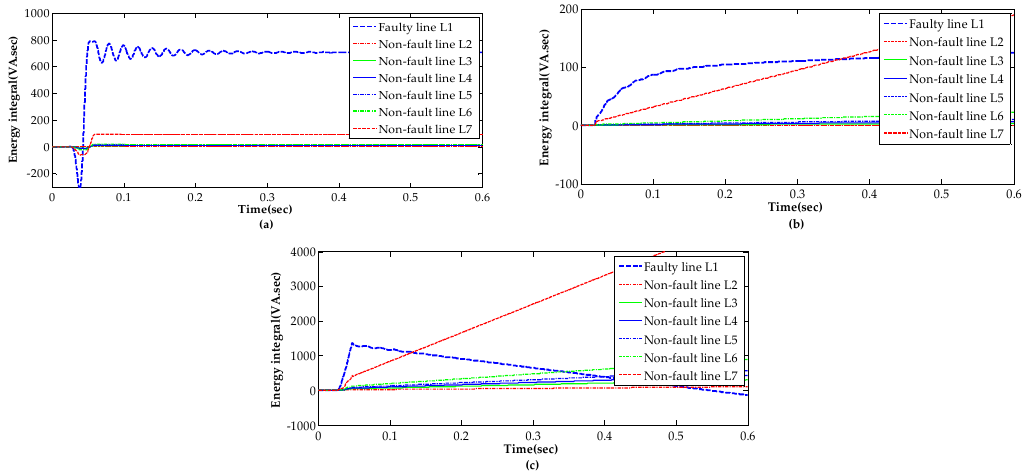
Figure 13. Comparison of the three energy integral schemes under a metal SPG fault occurring on the line L 1 , at 2 km away from the bus, at 0° initial phase angle. ( a ) The results of the energy integral scheme in this paper; ( b ) the results of the energy integral scheme in [20]; ( c ) the results of the energy integral scheme in [21].